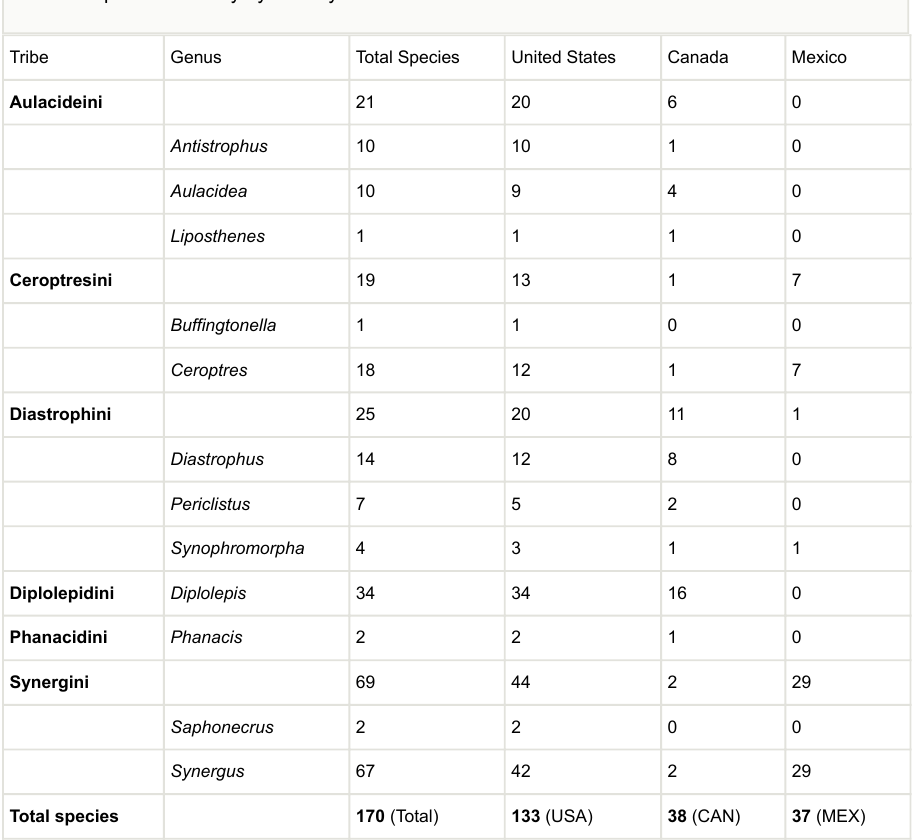
Table 1. Table 1: Species diversity by